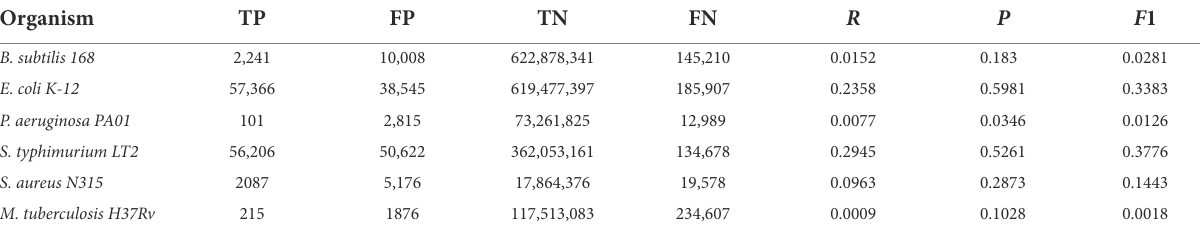
TABLE 3 Graphlets absence comparison between the six reference networks employed in this work and their counterparts generated following our homology-based transfer approach from the other remaining networks.